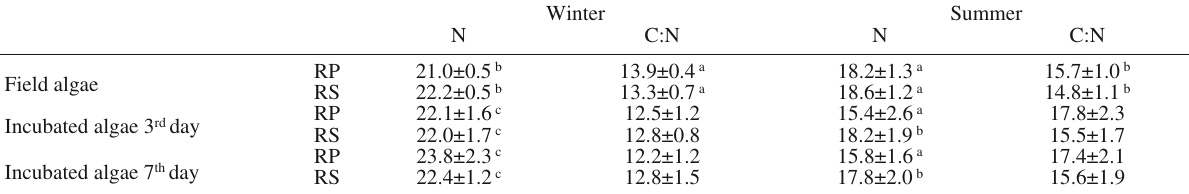
Table 4. – Concentration of internal N expressed as mg g –1 DW and C:N ratio in C. tamariscifolia collected in winter (February) and summer (July) from rocky shores (RS) and rockpools (RP) from field material (field algae) and after 3 and 7 d incubation in 1.5-L UV-transparent cylindrical vessels under solar radiation (incubated algae). Data are expressed as mean±standard deviation of n=6 and lower-case letters denote significant differences after SNK test.